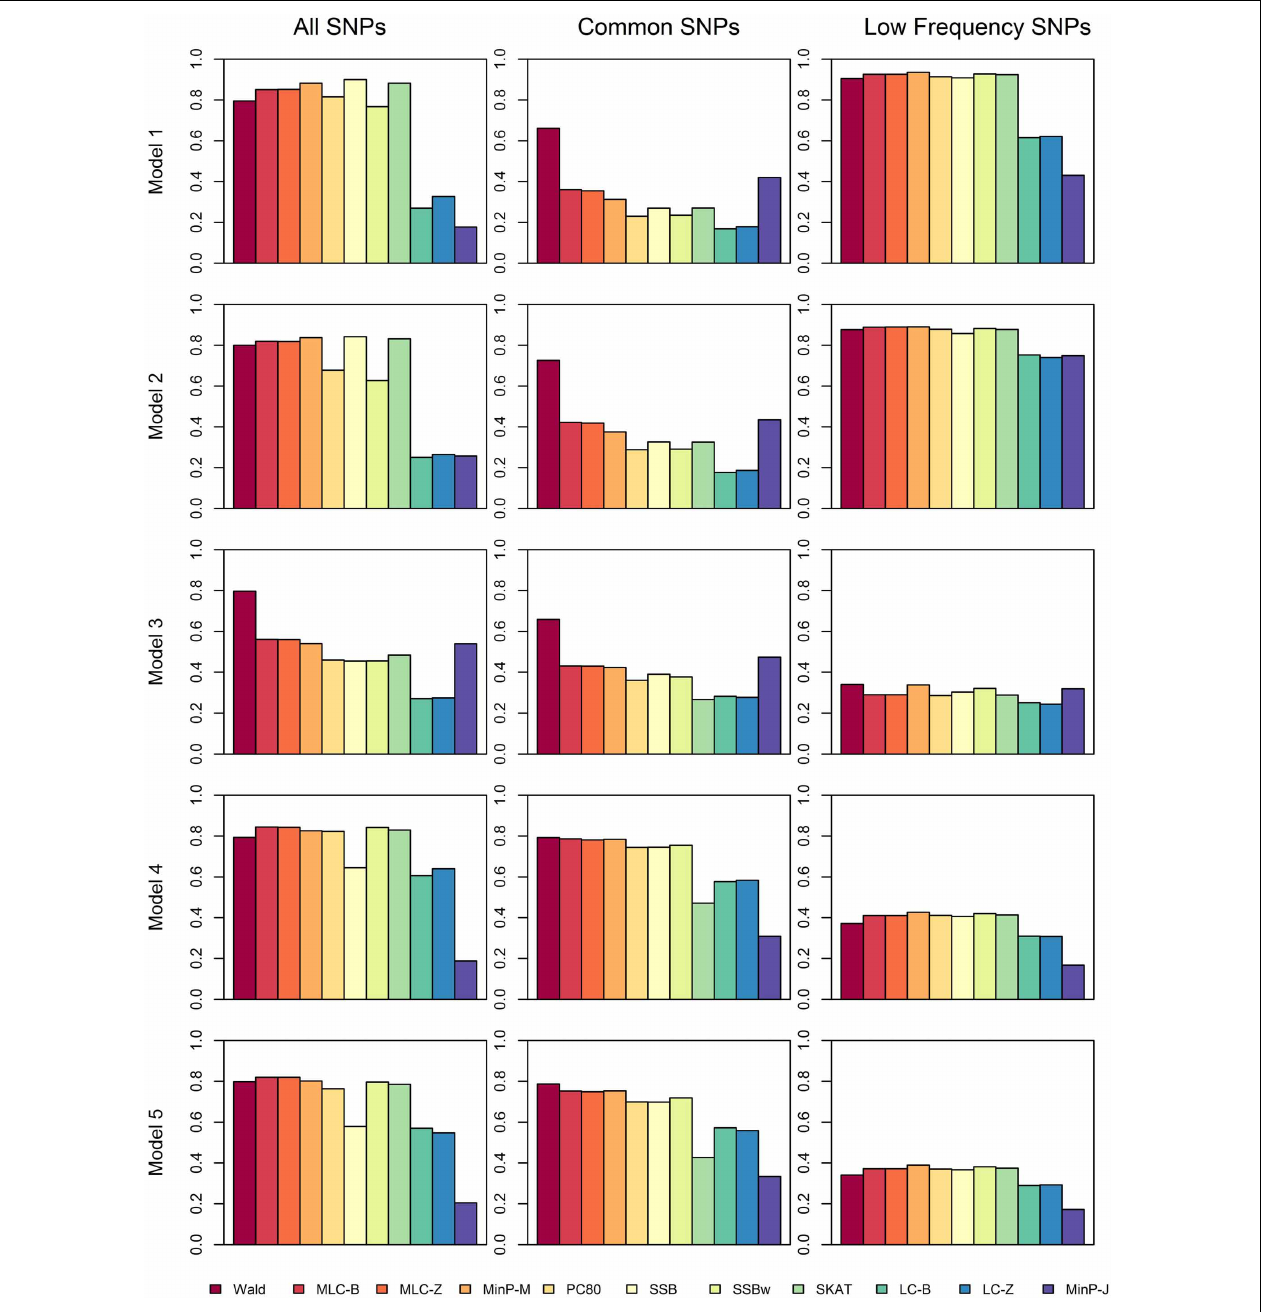
FIGURE 2 | Averaged empirical power of gene-based tests for three analysis sets obtained under five different trait models.